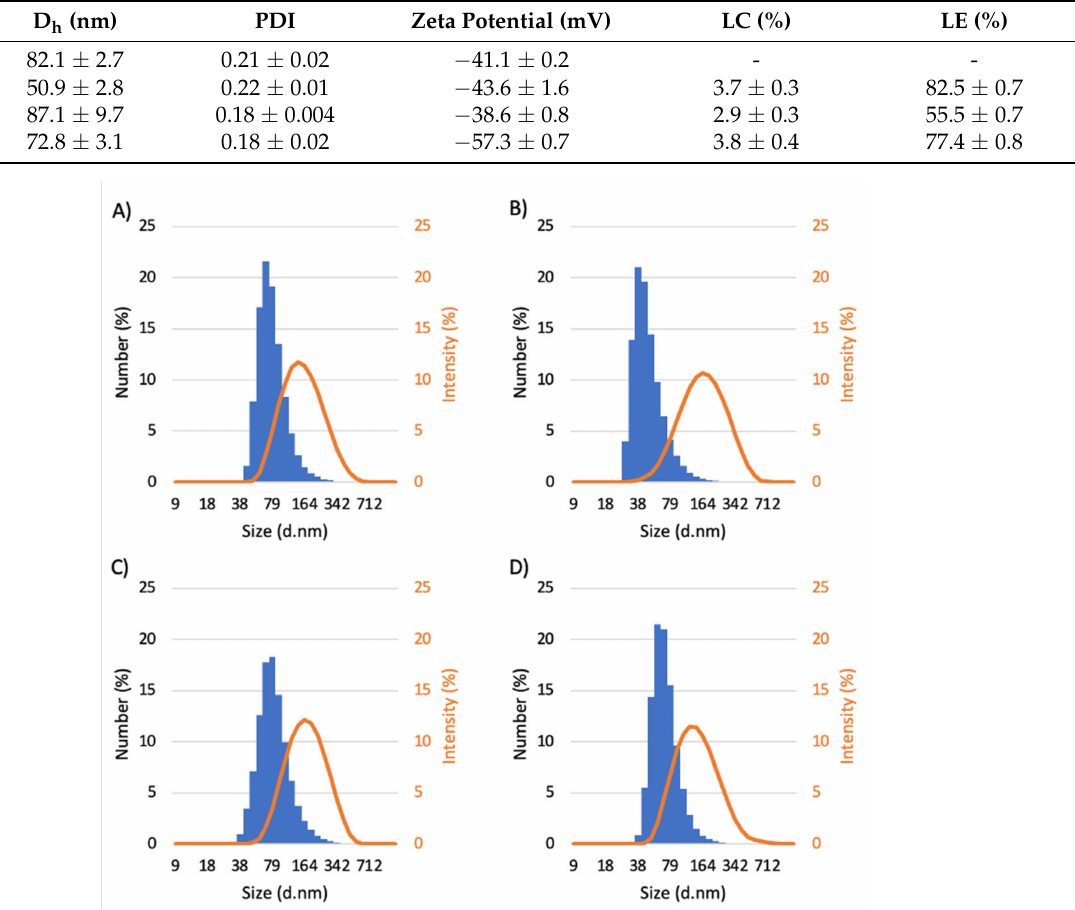
Figure 3. DLS histograms of ( A ) BCMs; ( B ) PQ-BCMs; ( C ) AuSe-BCMs; and ( D )